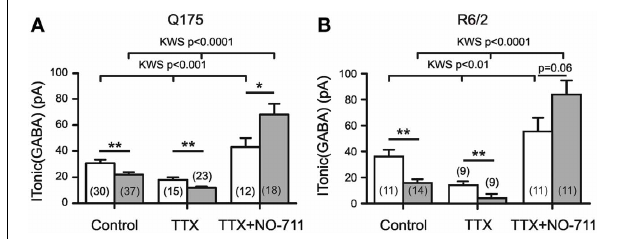
Tonic ( GABA ) . Recording conditions and supplements as in Figure 1A . (A,B) Results from two different types of HD mice. TTX (1 µ M) reduces I Tonic ( GABA ) without abolishing the HD-related difference. Block of GAT-1 with NO-711 (10 µ M) increases I Tonic ( GABA ) . Note significantly stronger effect of NO-711 in HD mice (filled bars). In both graphs, the data sets of the 6 columns were independent, not paired. In the 3 groups for Control, TTX, and TTX + NO-711 the means from WT vs. HD were compared according to Mann–Whitney tests (see Table 1 for more details). In addition, we have performed Kruskal–Wallis statistics (KWS) to compare the differences between Control, TTX, and TTX plus NO-711 in WT and HD. The respective values were as follows. Q175 WT: KWS = 15 . 23, p < 0 . 001; Q175 HD: KWS = 50 . 91, p < 0 . 0001. R6/2 WT: KWS = 12 . 40, p < 0 . 01; R6/2 HD: KWS = 23 . 94, p < 0 . 0001. The asterisks denote: ∗ p < 0 . 05, ∗∗ p < 0 .